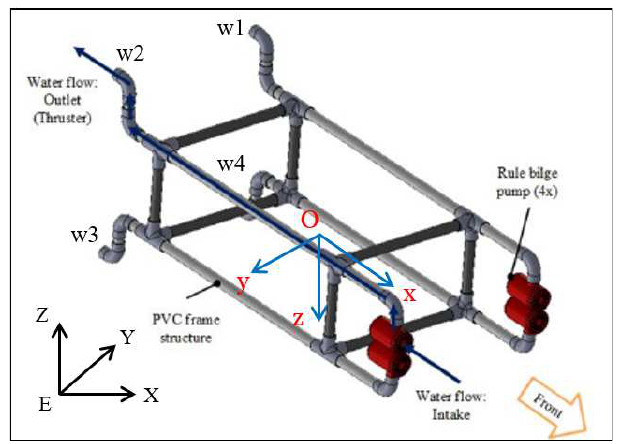
Figure 1. Mechanical design and propulsion